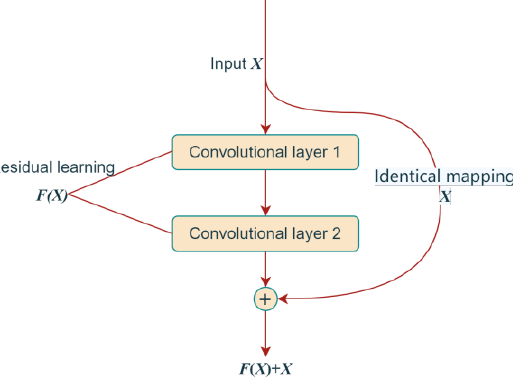
Figure 2. Schematic diagram of the residual module.